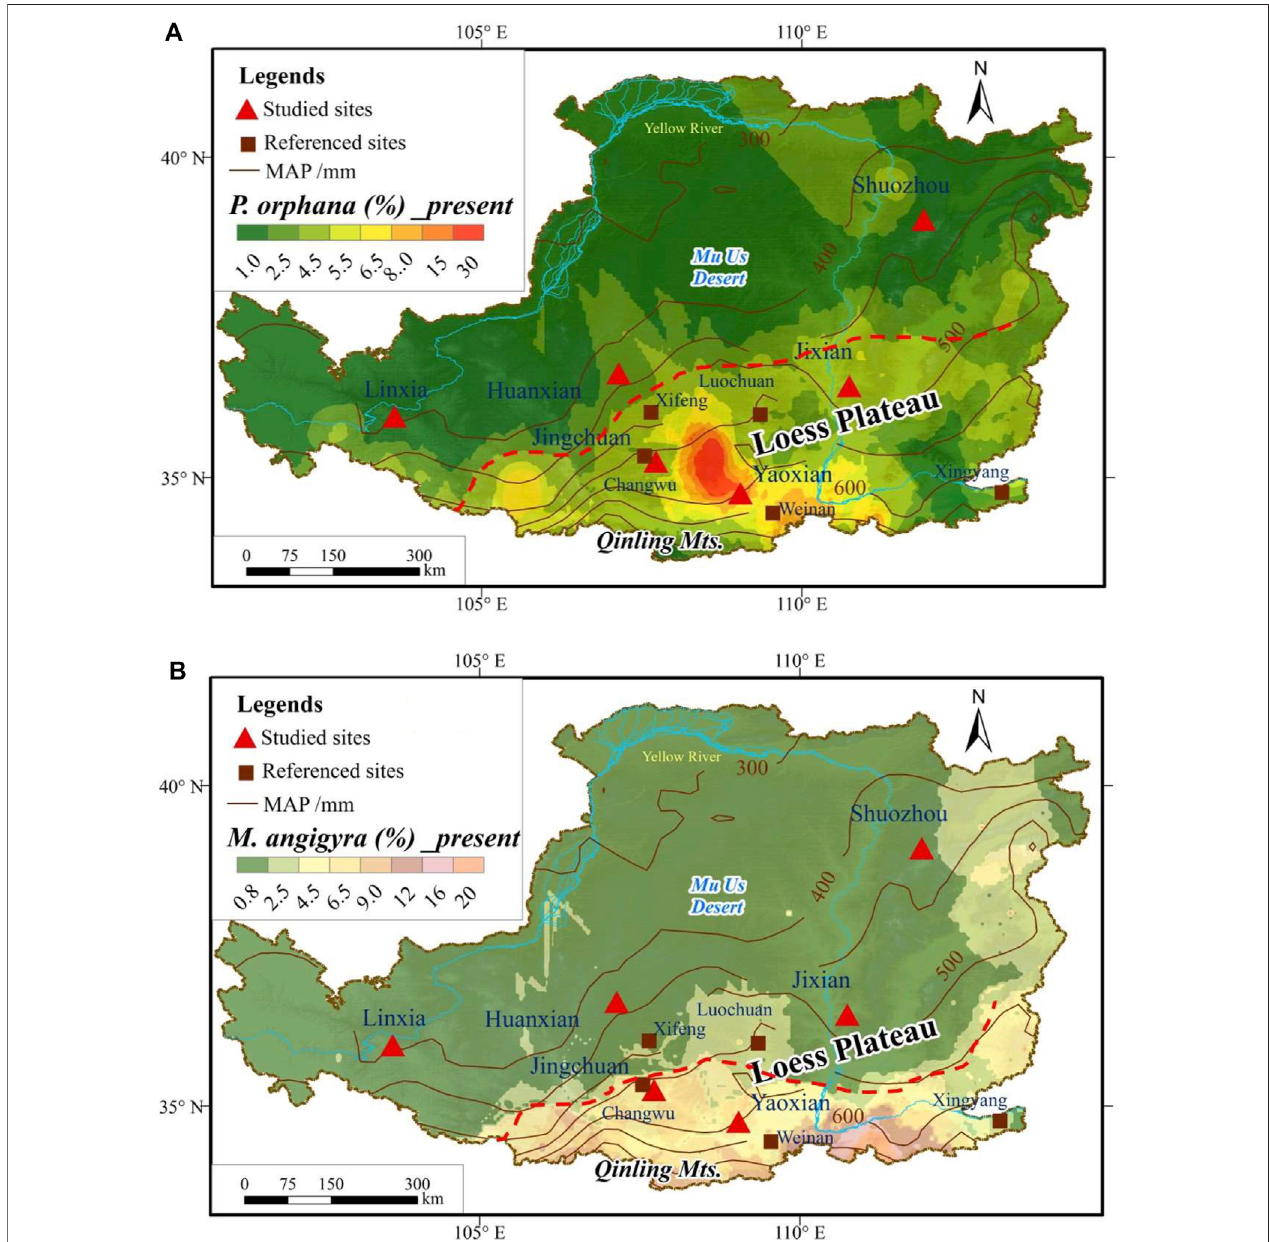
FIGURE 2 | Maps of the abundance of P. orphana (A) and M. angigyra (B) based on modern surveys (Li et al., 2016; Dong et al., 2019, 2020a), together with modern mean annual precipitation over the past 50 years. Red dotted lines show the reference values of the 4.5%, 2.5% isolines of P. orphana and M. angigyra ,